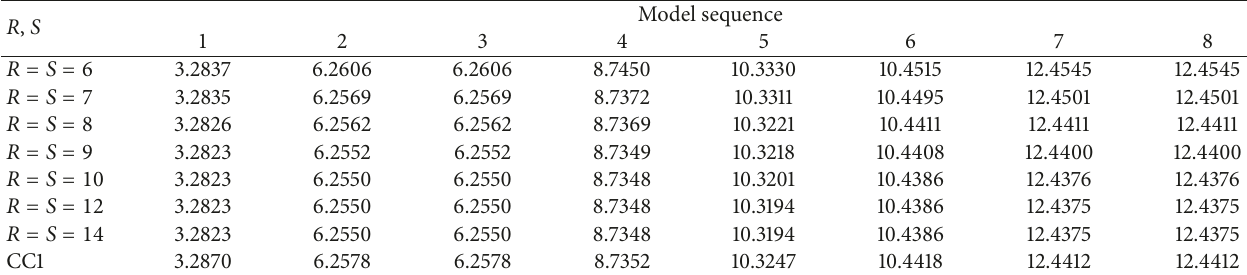
Table 5: Frequency parameters Ω = 𝜔𝑏 2 (𝜌ℎ/𝐷) 1/2 /𝜋 2 for the multipoint-supported square plate; the numbers of clamped points is 26 on every edge.